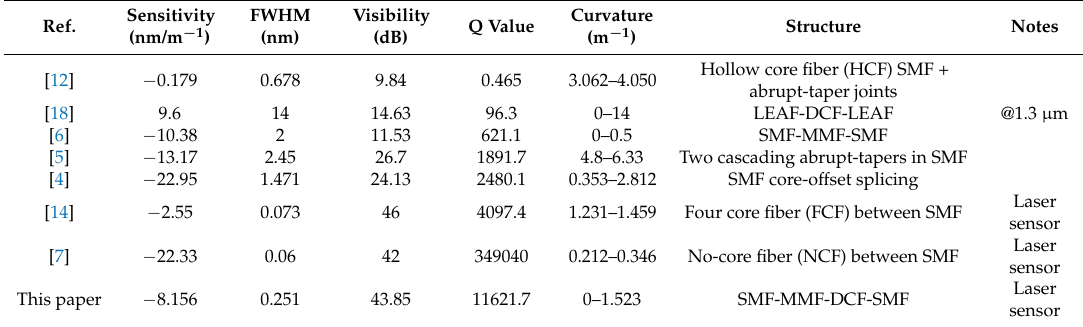
Table 1. Comparison between similar reported in-fiber sensors and this